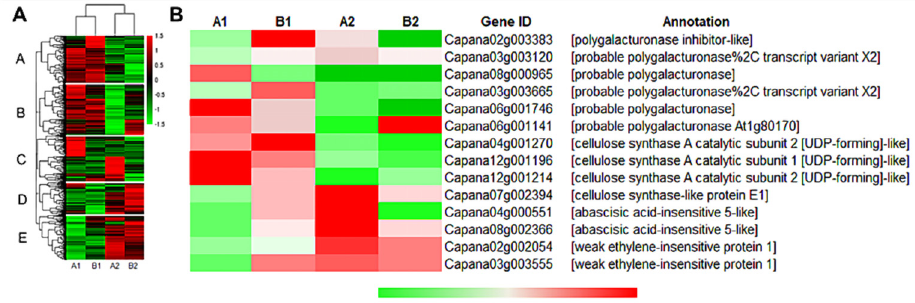
Figure 4. Heat map analysis of storage tolerance genes. Annotation: ( A ) Genes or samples with sim- ilar expression patterns in the heat map are gathered together. The color in each grid does not reflect the gene expression value, but the value obtained after homogenizing the rows of expression data (generally between − 2 and 2), so the colors in the heat map can only be compared horizontally (the expression of the same gene in different samples); vertical comparison (expression of different genes in the same sample) is not allowed. ( B ): Expression of representative genes among different samples.